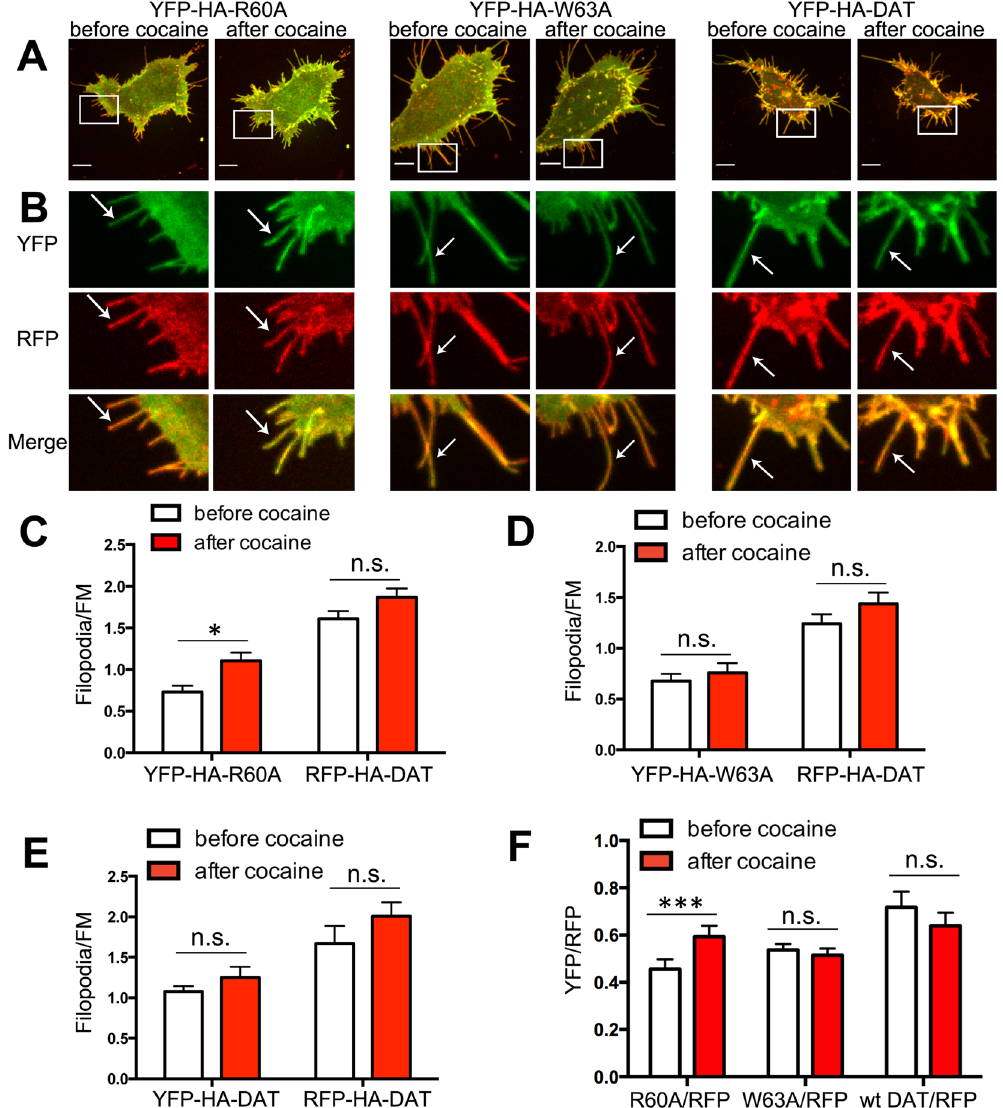
Figure 4. Binding of cocaine results in the enrichment of the R60A mutant relative to co-expressed wt DAT in the filopodia of HEK293 cells. ( A ) HEK293 cells co-expressing RFP-HA-DAT with YFP-HA-DAT, YFP- HA-DAT-R60A or YFP-HA-DAT-W63A were imaged through 515 nm (YFP, green ) and 561 nm (RFP, red ) filter channels before and after cocaine treatment (30 min at RT). Maximal z-projections of 5 consecutive x-y-confocal planes are shown. Scale bars, 10 μ m. ( B ) Insets represent high magnification images of the regions marked by the white rectangle in ( A ). Arrows point to examples of peripheral filopodia. ( C–E ) The Filopodia/FM ratios of YFP and RFP fluorescence intensities in cells co-expressing RFP-HA-DAT with YFP- HA-R60A ( C ), YFP-HA-W63A ( D ) or wt YFP-HA-DAT ( E ) were calculated in experiments exemplified in ( A,B ) as described in “Methods”. Results are shown as mean ± SEM, n = 10. ( F ) The YFP/RFP ratio in filopodia was calculated in experiments represented in ( A,B ). Results are shown as mean ± SEM, n = 10. * p < 0.05, *** p < 0.001. * p < 0.05, *** p <